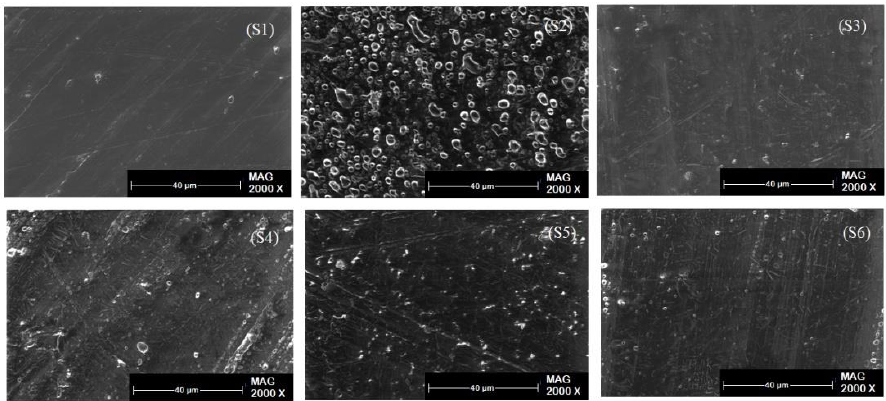
Fig. 3. SEM Images of the surface of 6 formulations (S1-S6), Mgnification